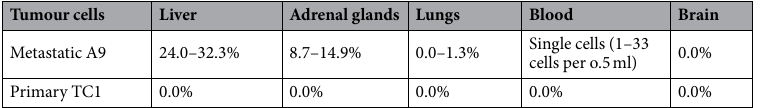
Table 1. Circulating tumour cells originating from metastatic tumours can be detected in distal organs. Primary TC1 and metastatic A9 tumour cells stably transfected with an EGFP-expressing vector were used to established subcutaneous tumours in WT C57Bl/6 mice. The appearance of EGFP-positive circulating tumour cells beyond the original site in distal organs was detected through the use of flow cytometry. CTCs originating from metastatic tumours can be detected in distal